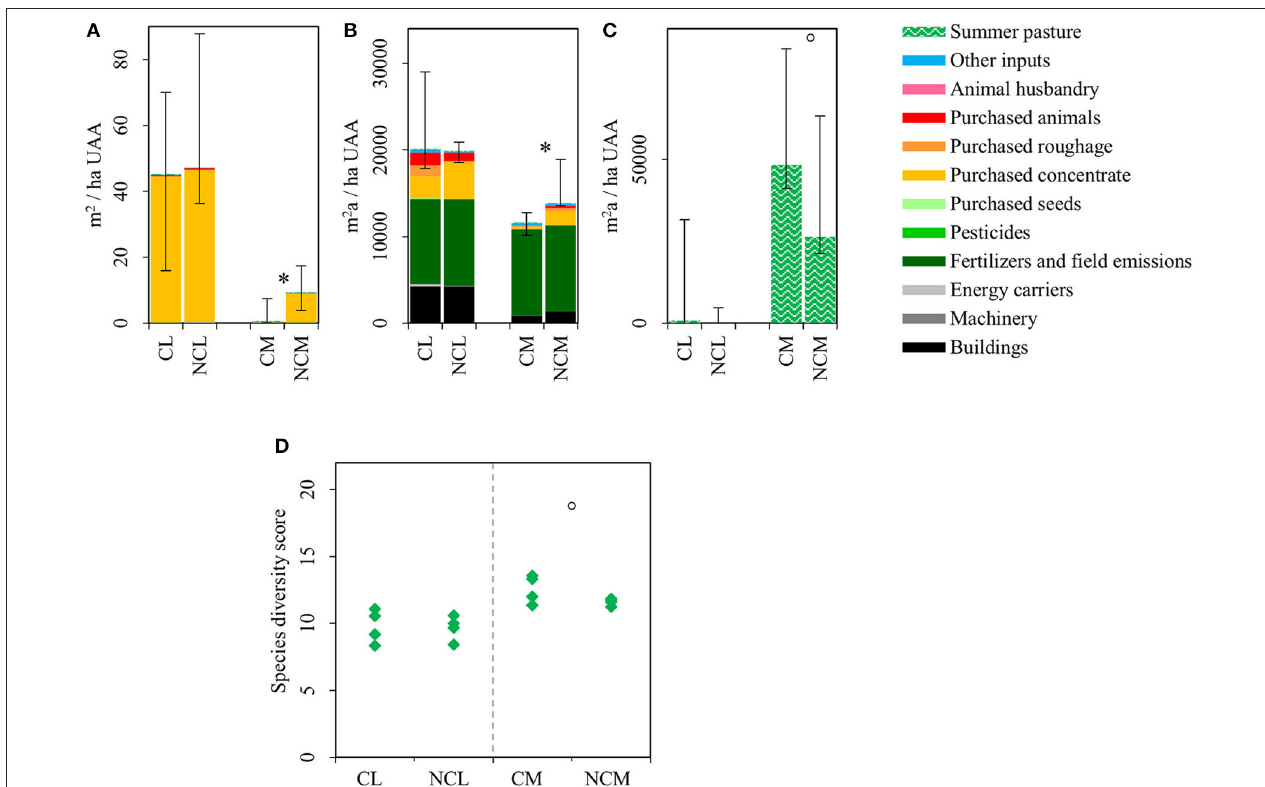
FIGURE 4 | Environmental impacts per hectare usable agricultural area (ha UAA) for impact categories related to land use. Top: (A) deforestation, (B) land competition, (C) alpine summer-pasture land use. Bars indicate median performance of each farm group and sources of impacts. Whiskers indicate minimum and maximum impacts within each group (CL, collaborating lowland farms; NCL, non-collaborating lowland farms; CM, collaborating mountain farms; NCM, non-collaborating mountain farms). Bottom: (D) Biodiversity of the UAA expressed as overall species diversity scores, *indicates significant differences between farm groups within the same region ( p < 0.05), and ◦ indicates tendencies ( p ≤ 0.1).